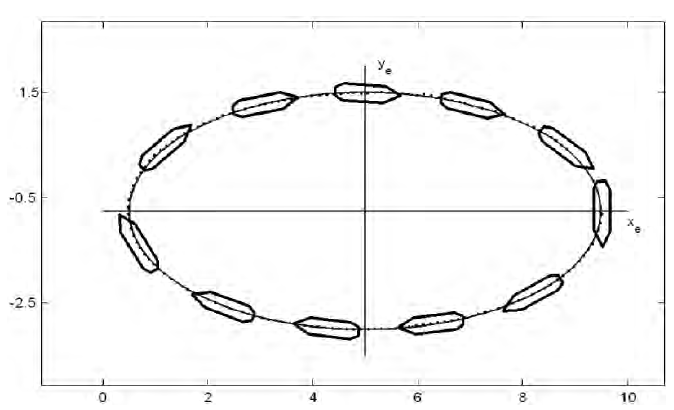
Figure 12. CyberShip II tracing the desired